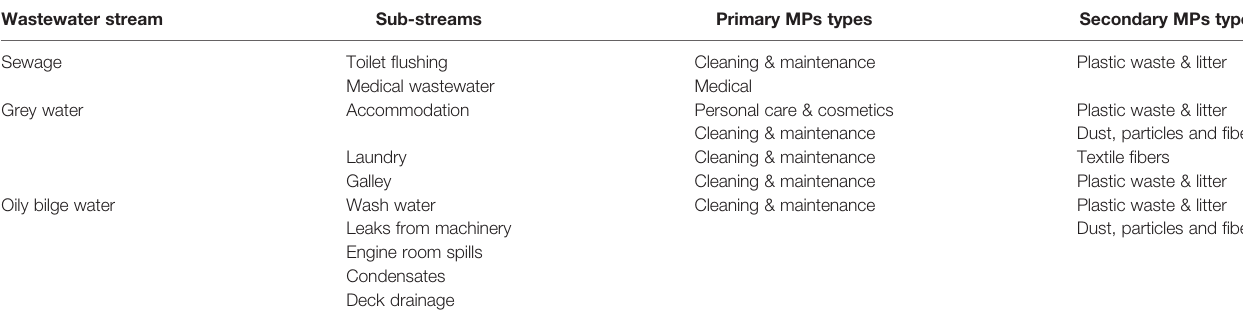
TABLE 7 | Linking cruise ship wastewater streams to pathways and microplastic